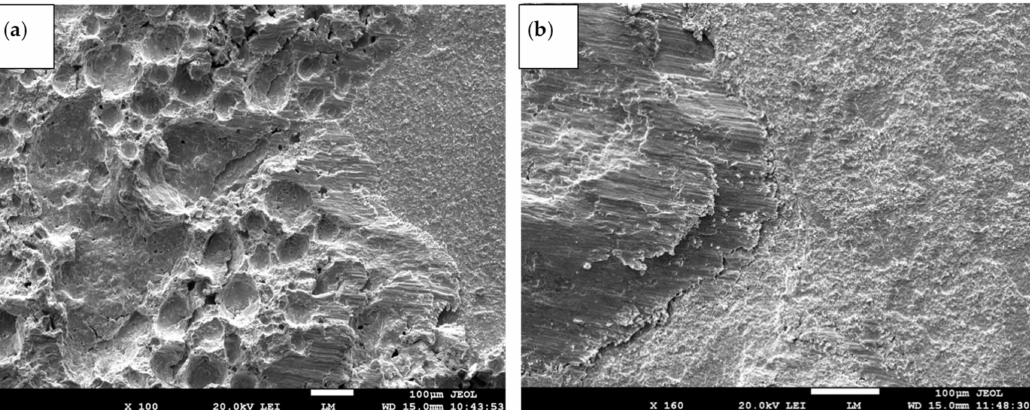
Figure 20. The fractured surface of soldered joint of Al7075/Zn5Al3Cu/Cu: ( a ) magnification 100 × ; ( b ) magnification 160 × .